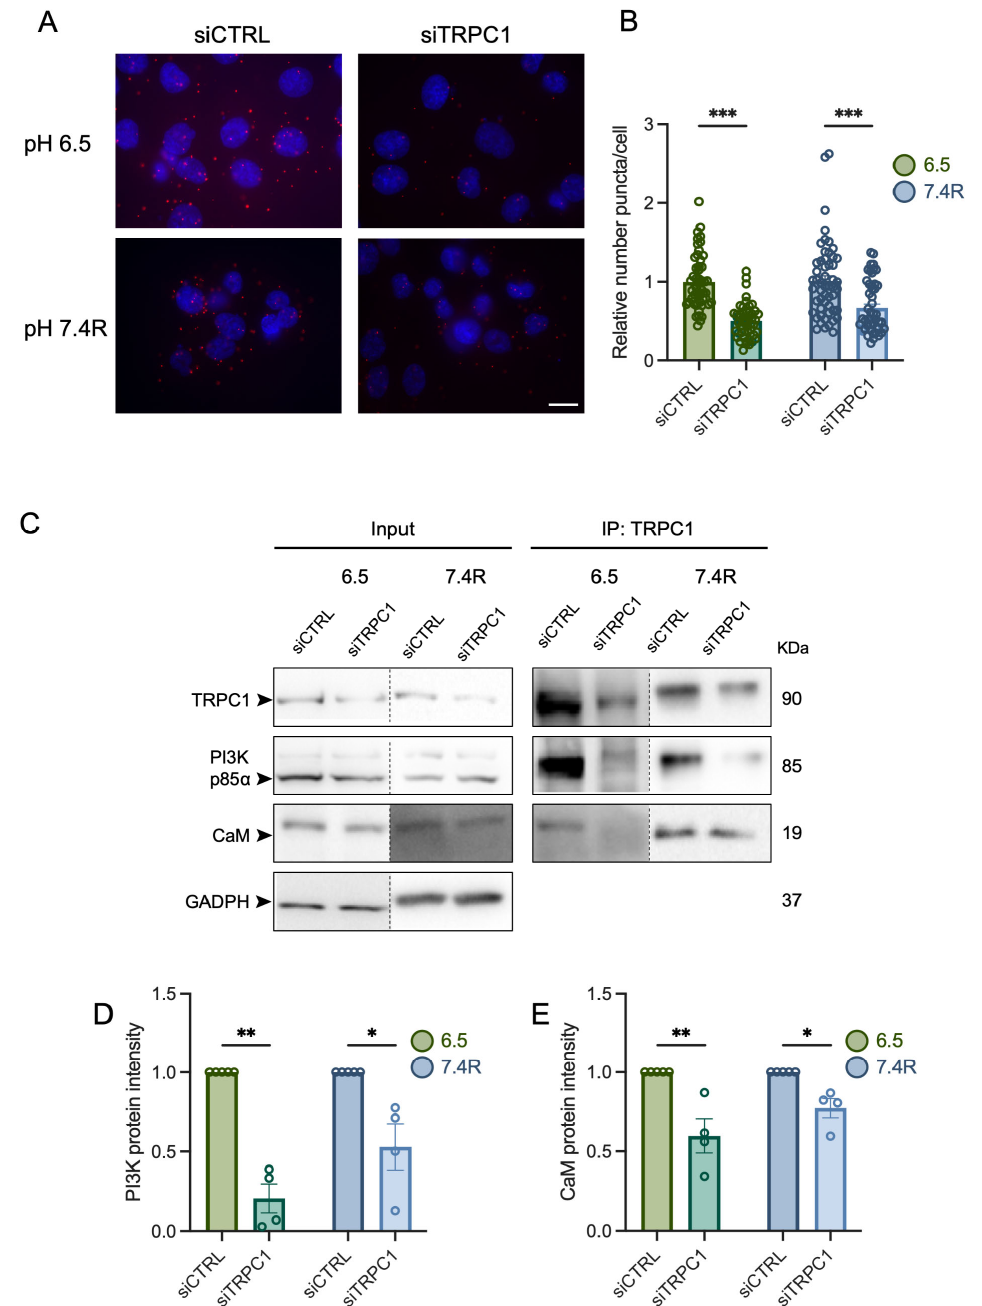
S3B. The uncropped blots are shown in File S1.